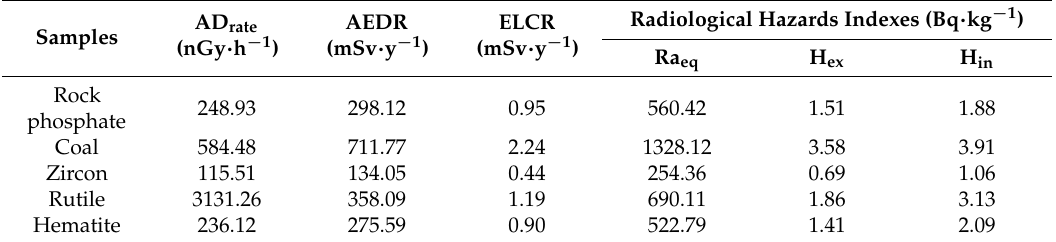
Table 6. Calculated absorbed dose (AD rate ), annual effective dose rate (AEDR), excess lifetime cancer risk (ELCR), and radiological hazard indexes (Ra eq , H ex , H in ).